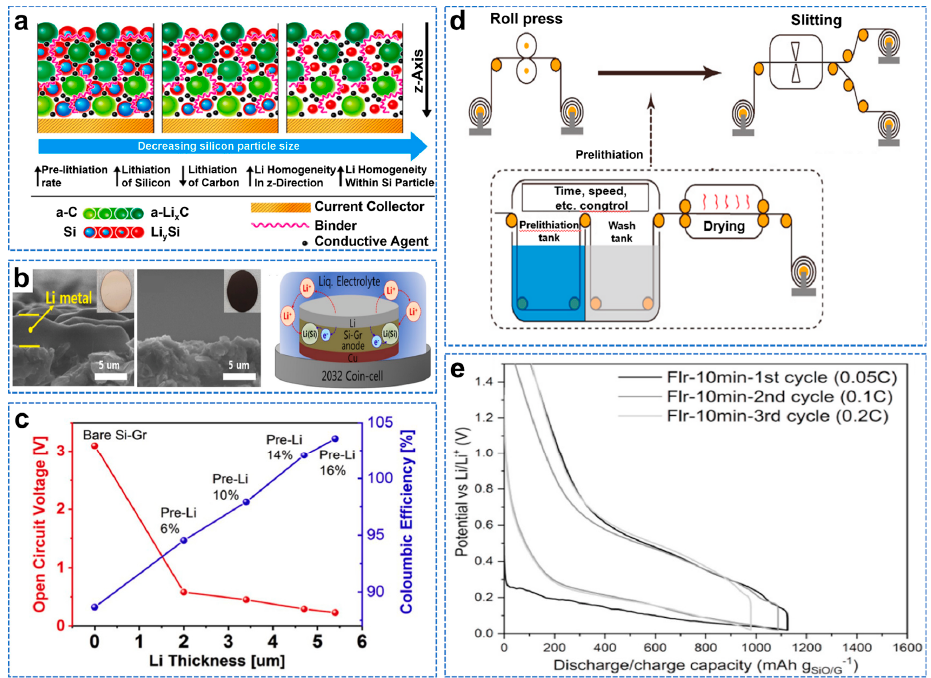
Figure 8. ( a ) Schematic illustration of the impact of Si particle size on the pre − lithiation behavior of Si/C composite anode materials in LIB cells, dependent on the Si particle size and electrode thickness (z − direction) [77]. ( b ) SEM images of the Li − evaporated Si − Gr anode, pre − lithiation Si − Gr anode and schematic representation of the pre − lithiation reaction process, ( c ) The open circuit voltages and the Coulombic efficiencies of the pre − lithiation Si − Gr anodes at different evaporated Li + thicknesses [79]. ( d ) Schematic diagram of SiO pre − lithiation, ( e ) Lithiation/de − lithiation curves of the cell made with Flr − 10min half − cell during formation process [81].